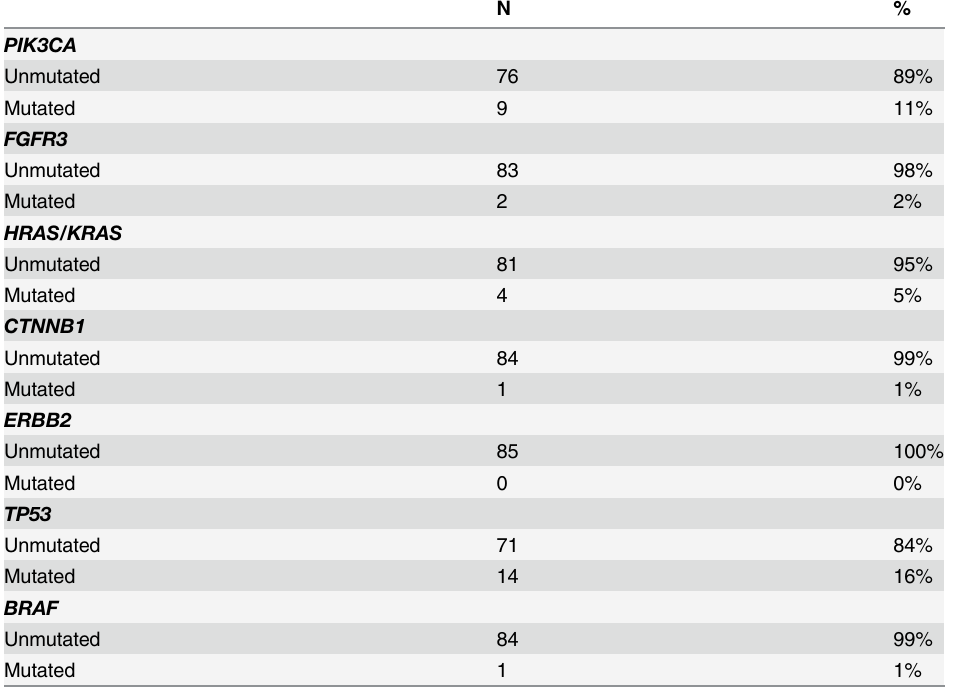
Table 3. Mutation status of